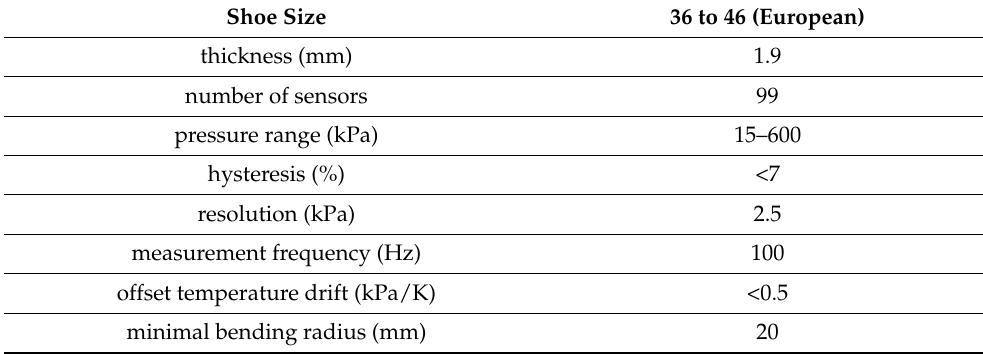
Table A3. Plantar pressure insoles technical specifications (Novel gmbh, PedarX) [40].